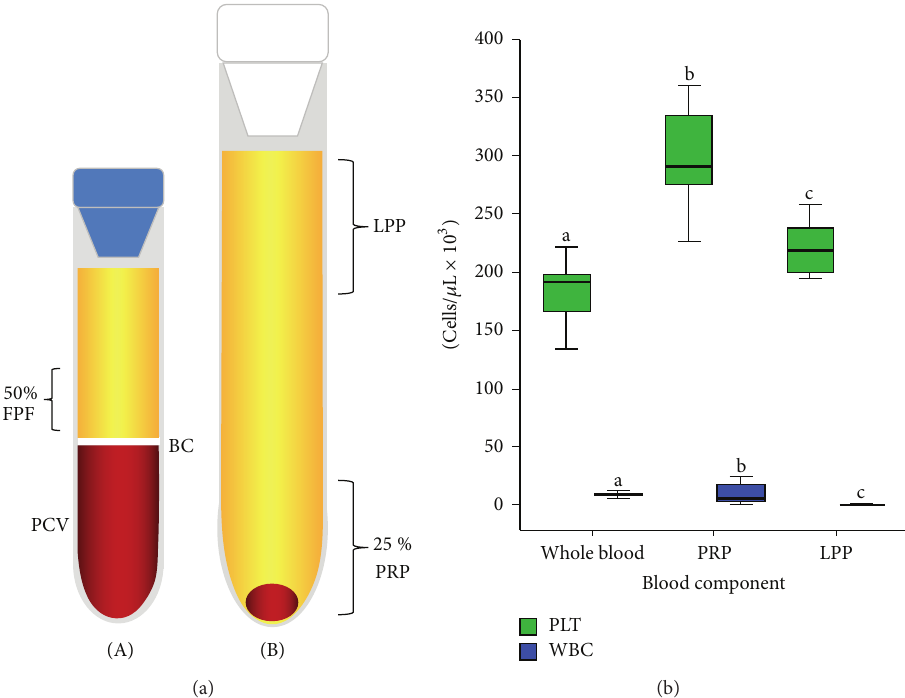
Figure 1: (a) Graphic illustrating the plasma fractions obtained from the tube-method protocol. The left tube (A) contains the first plasma fraction (50%)(FPF)obtained by thesinglecentrifugation tubemethod. Therighttube(B)containsplatelet-rich plasma (PRP)and leukocyte- poor plasma (LPP). BC: buffy coat. PCV: packed cell volume. (b) Graphic illustrating the platelet (PLT) and leukocyte (WBC) mean ( ± SD) concentrations in whole blood, PRP, and LPP. a-b Different lowercase letters represent significant differences for the count of each cell in every blood component ( 𝑃 > 0.001